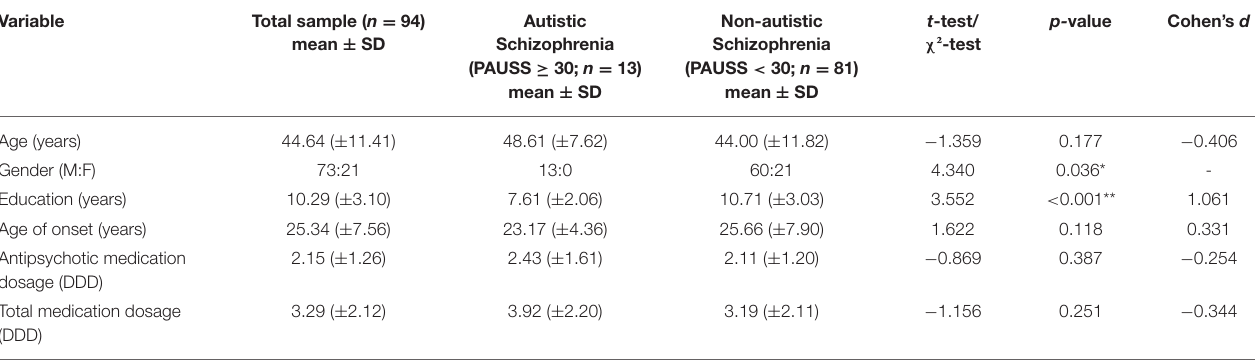
TABLE 1 | Between-group comparison for socio-demographic characteristics.